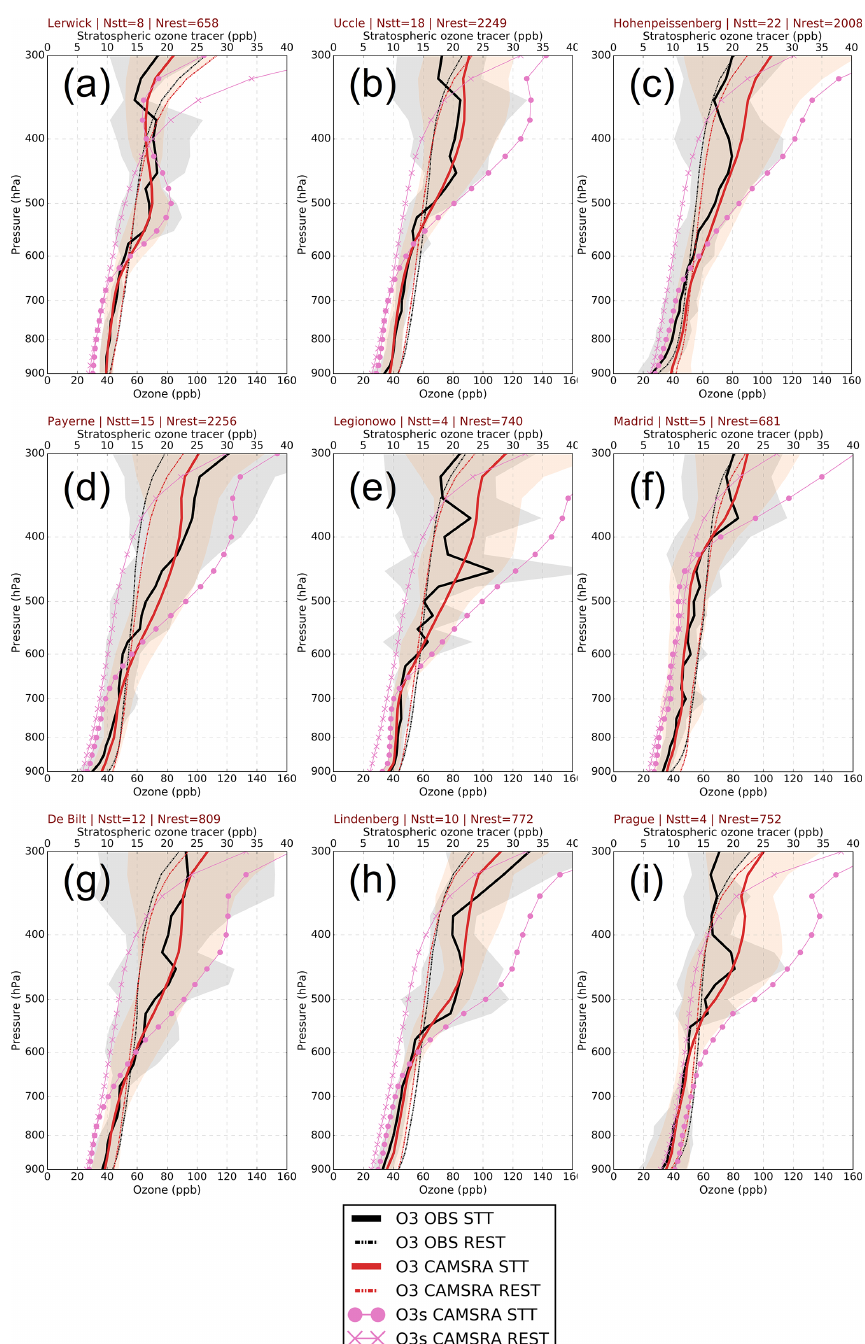
Figure 4. Vertical profiles of observed (black) and CAMSRA (red) ozone concentrations (ppb) during STT events (thick solid line) and during the rest of the events (thin dashed line) at the WOUDC ozonesonde stations of (a) Lerwick (UK), (b) Uccle (Belgium), (c) Hohenpeissenberg (Germany), (d) Payerne (Switzerland), (e) Legionowo (Poland), (f) Madrid (Spain), (g) De Bilt (the Netherlands), (h) Lindenberg (Germany), and (i) Prague (Czech Republic). Also shown are the vertical profiles of stratospheric ozone tracer concentrations (ppb) during STT (pink circles) and the rest of the events (pink crosses). The grey and sandy brown areas depict the ± 1 standard deviation of ozone vertical profiles during STT events in observations and CAMSRA, respectively. Keep in mind that O 3 and O 3s concentrations are presented on different horizontal